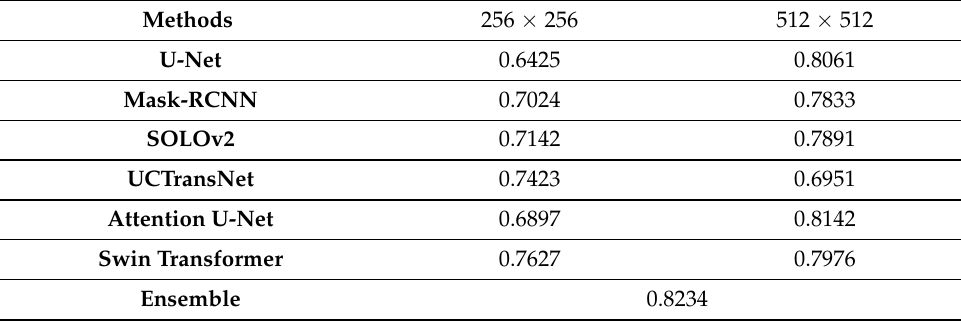
Table 2. mIoU for different neural network segmentation.